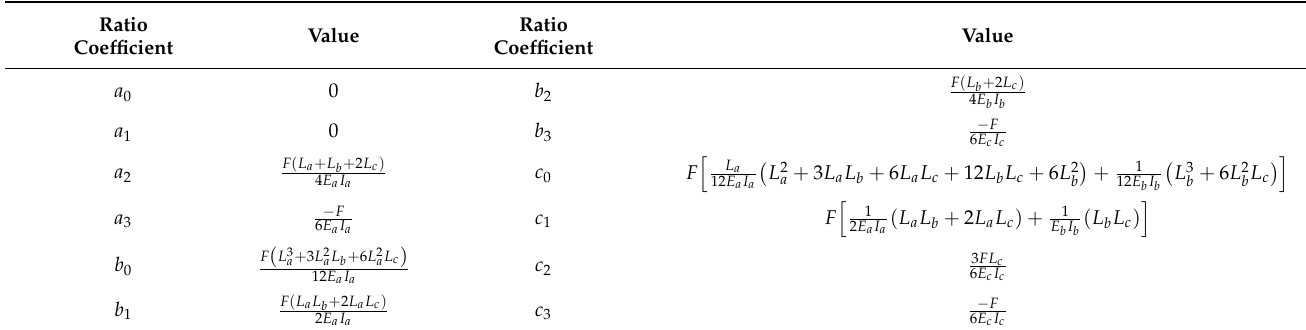
Table 1. Calculated result of ratio coefficient in Equation (10).